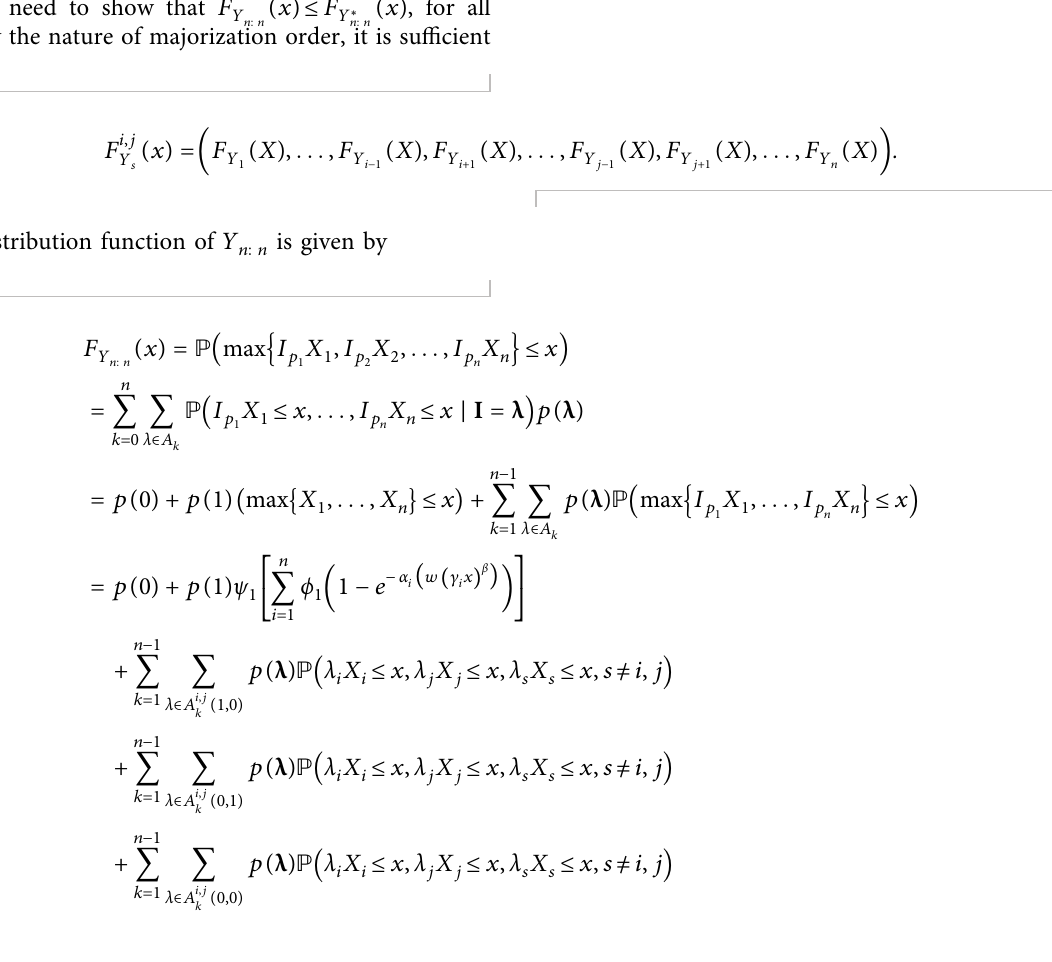
( x ) and F ( x ) Y 2 : 2 Y ∗ 2 : 2